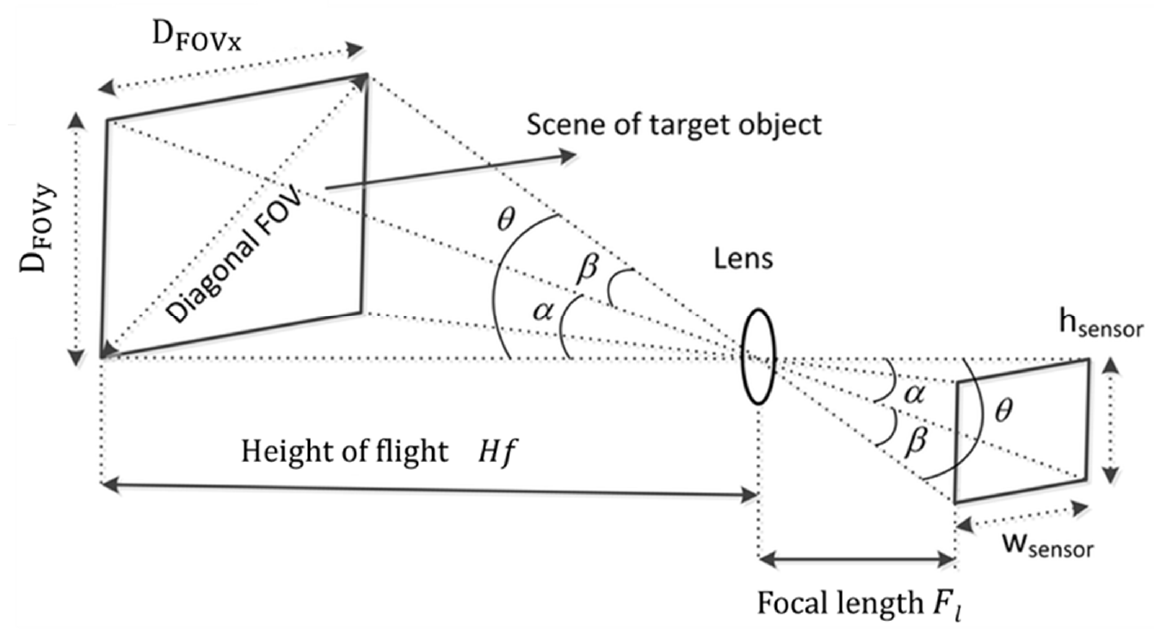
Figure 5. Field of view and camera parameterization.